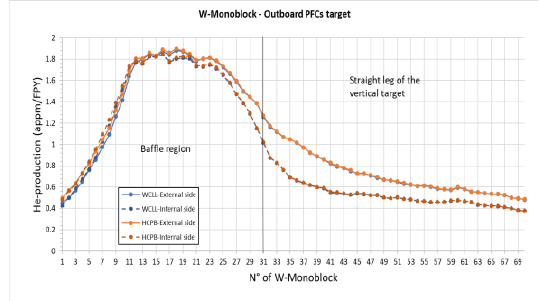
Figure 37. Outer poloidal profiles of the He-production (appm/FPY) on W-Monoblocks, comparing